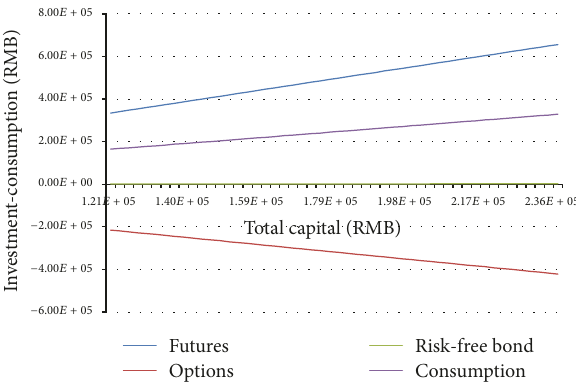
Figure 2: Optimal strategies under 𝛾 1 + (𝜎 2 1 (𝑡) + 𝜆(𝑡)𝜑 2 1 (𝑡))( ̇𝛼(𝑡) / 𝛼(𝑡)) ≤ 𝛾